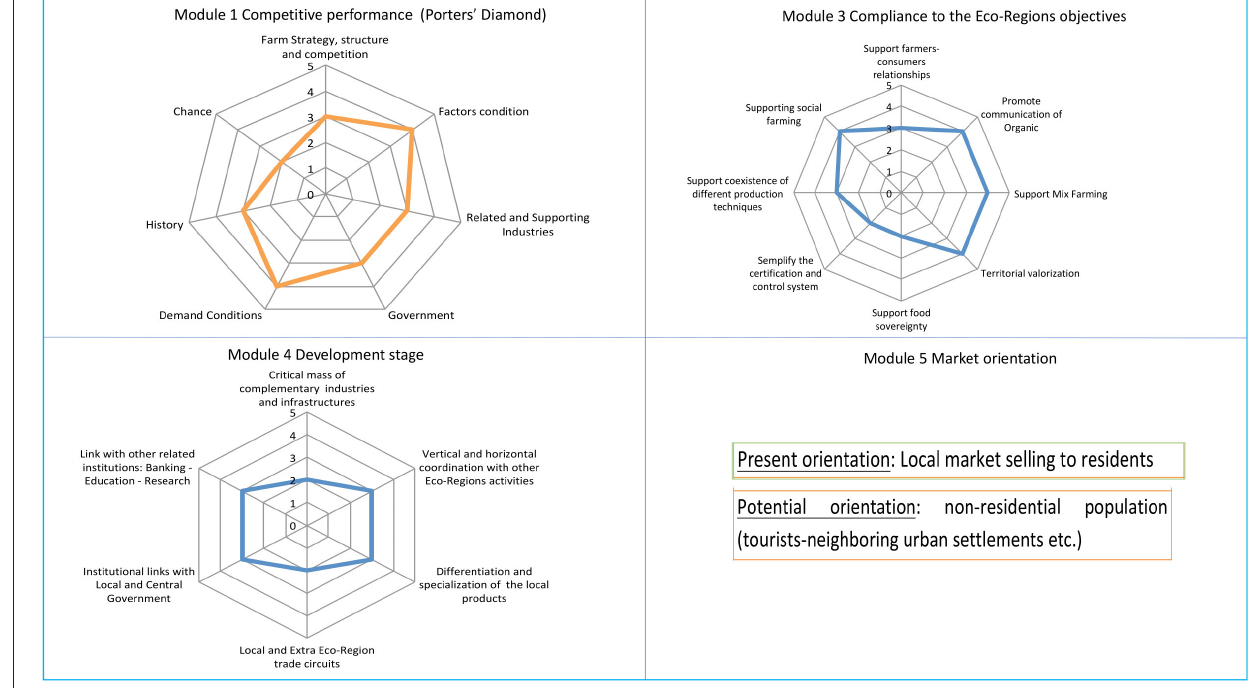
FIGURE 5 | Result of the Monitoring tool application to the Cilento Eco-Region. Adapted from Pugliese et al. (2013) with permission from CIHEAM